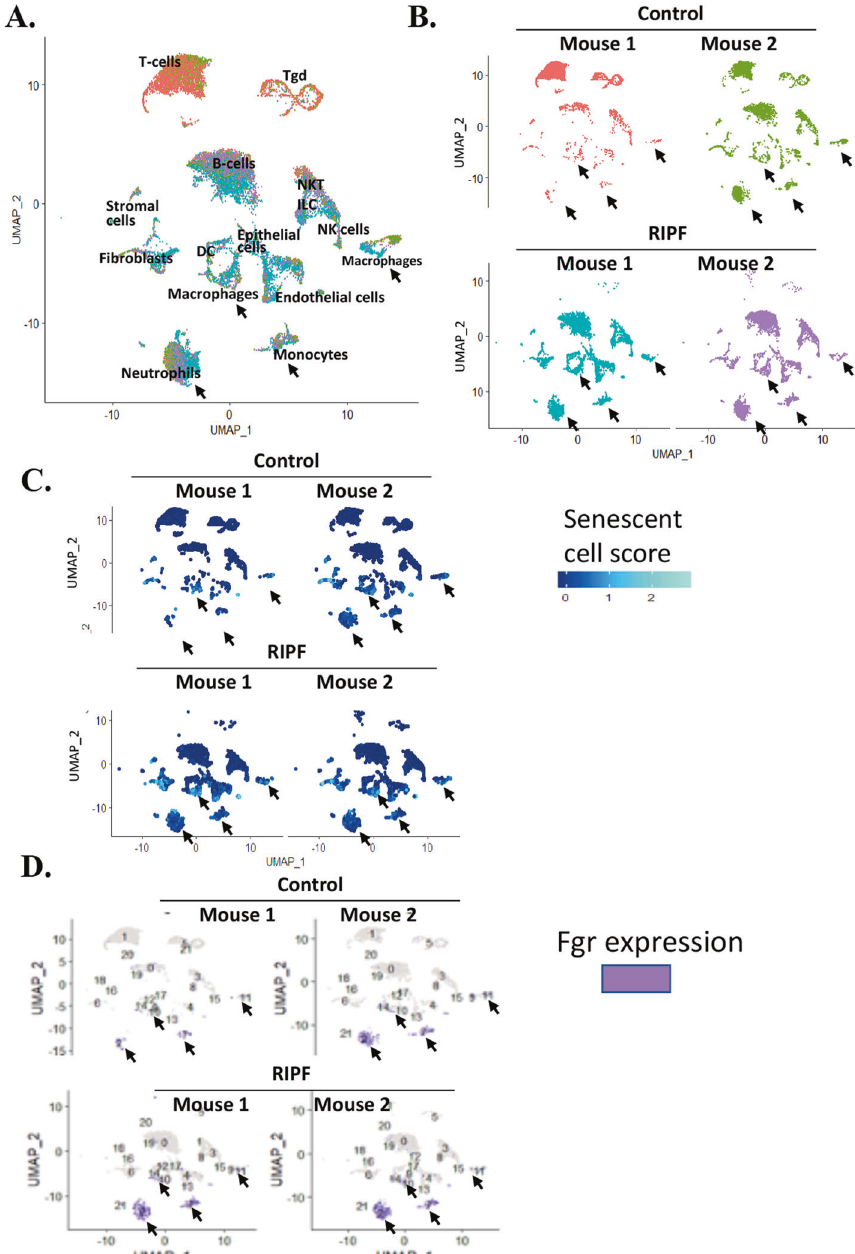
Fig. 8 Single-cell RNA-Seq analysis of mice with radiation-induced pulmonary fi brosis. A Single-cell RNA-Seq was performed on single-cell suspensions generated from two control and two 150 days post-irradiated (20 Gy) irradiated mouse lungs with fi brosis. All samples were analyzed using canonical correlation analysis within the Seurat R package. Cells were clustered using a graph-based shared nearest-neighbor clustering approach and visualized using a U-map plot. Canonical cell markers were used to label clusters by cell identity as represented in the plot. Cell types were classi fi ed as indicated. B Cellular populations represented in all four samples are shown in UMAP plot identi fi ed. Each sample was color-coded to show the differences in cell types represented by control and irradiated lungs. The distribution of senescent cells is shown for both control and irradiated lungs cell types in the UMAP plot. We used the expression of canonical 23 senescence-associated gene expressions to generate a senescence score for any individual cell and applied it to all cell types in our dataset. The lighter the blue, the more the expression of the genes. C Distribution of Fgr expressing cells is shown for both control and irradiated lung cell types in the UMAP plot. D Purple color indicates the expression of Fgr. Stable shRNA knockdown of Fgr con fl uency, cells were sub-cultured and the remaining cells were tdTOMp16 cells were cultured at 70% con fl uency and 24 h after the cells processed for Fgr knockdown validation by RT-q-PCR and western blotting. were transfected with Lipofectamine 3000 reagent using non-target control and Fgr shRNAs. Transfected cell lines were sub-cultured after Transwell coculture experiments 24 h of transfection, and puromycin was added at 4 μ g/ ml concentration. A Transwell system (0.4- μ m pore size, polyester membrane; Corning, The culture media of the transfected plates were replaced with fresh media Kennebunk, ME) was used [66]. C57BL/6 mouse bone marrow stromal cells to eliminate dead non-resistant cells. Once the resistant cells reach 80% Cell Death Discovery (2021)